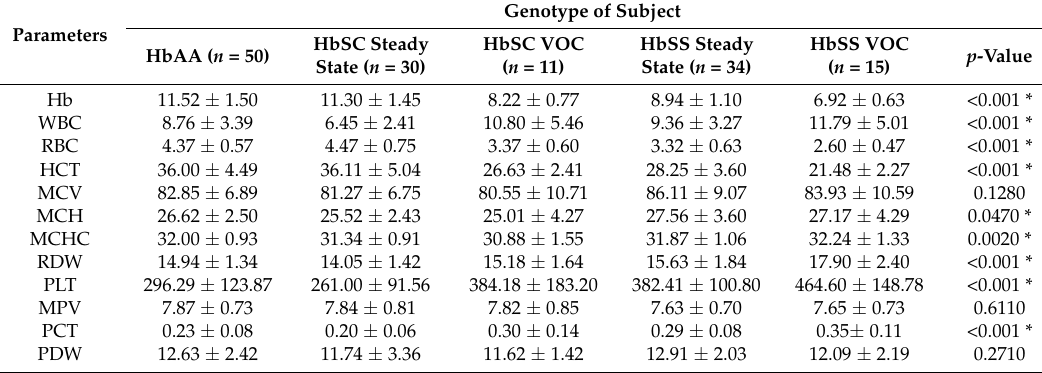
Table 1. Haematological parameters of study participants.